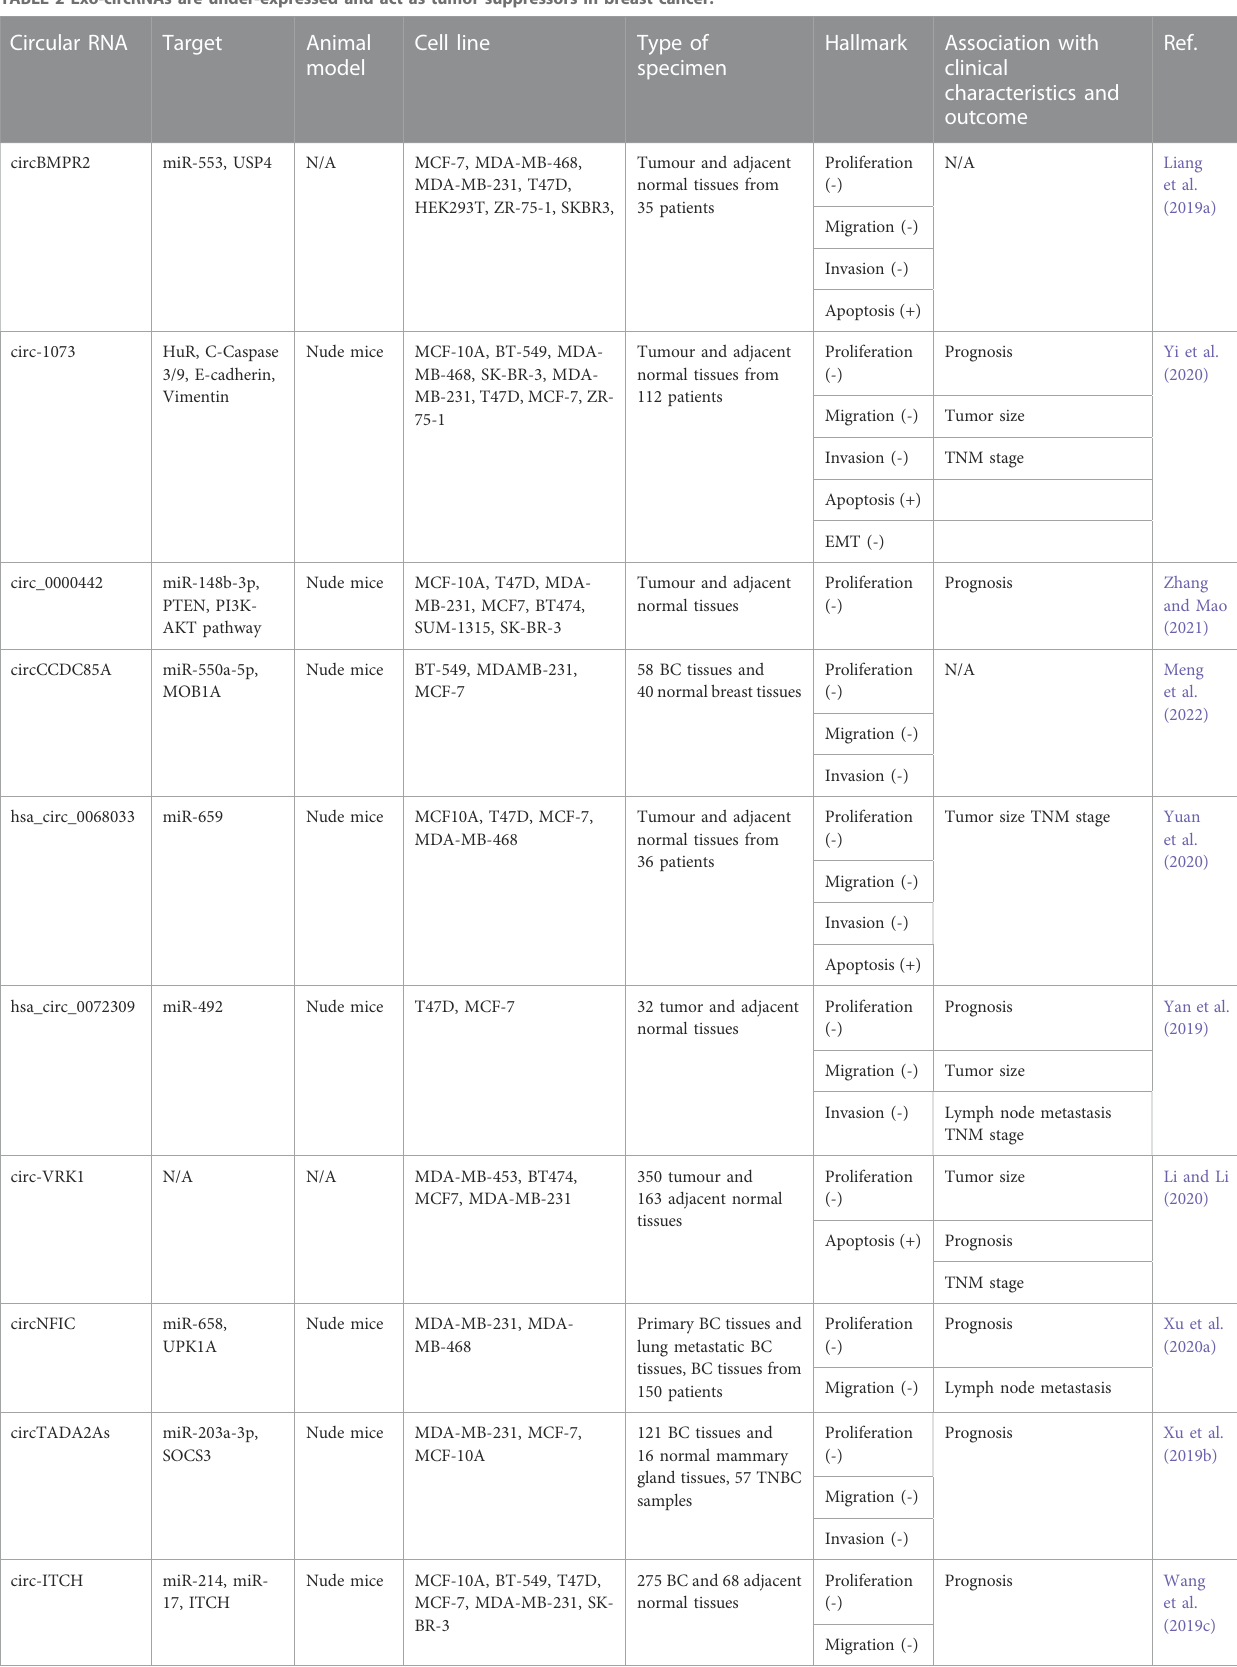
TABLE 2 Exo-circRNAs are under-expressed and act as tumor suppressors in breast cancer. Circular